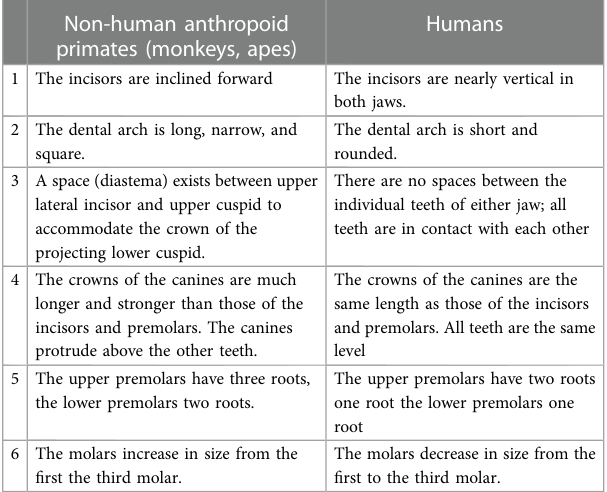
TABLE 1 Differences between human and non-human anthropoid primates dentitions [adapted from Kronfeld (119)]. Non-human anthropoid primates (monkeys, apes)